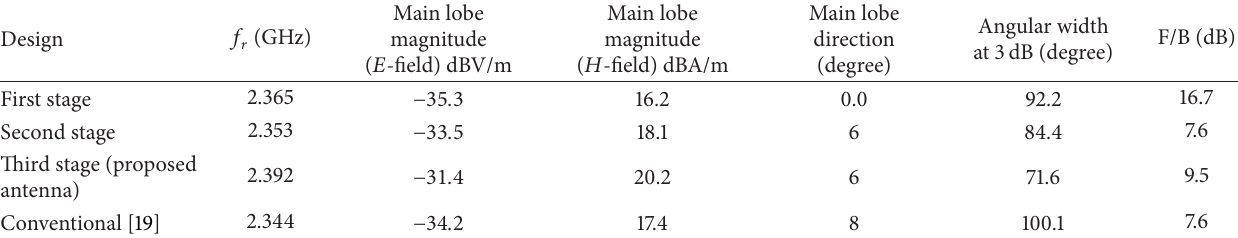
Table 2: Comparison of the directivity of the proposed antenna (three stages) and the conventional microstrip patch antenna [19].